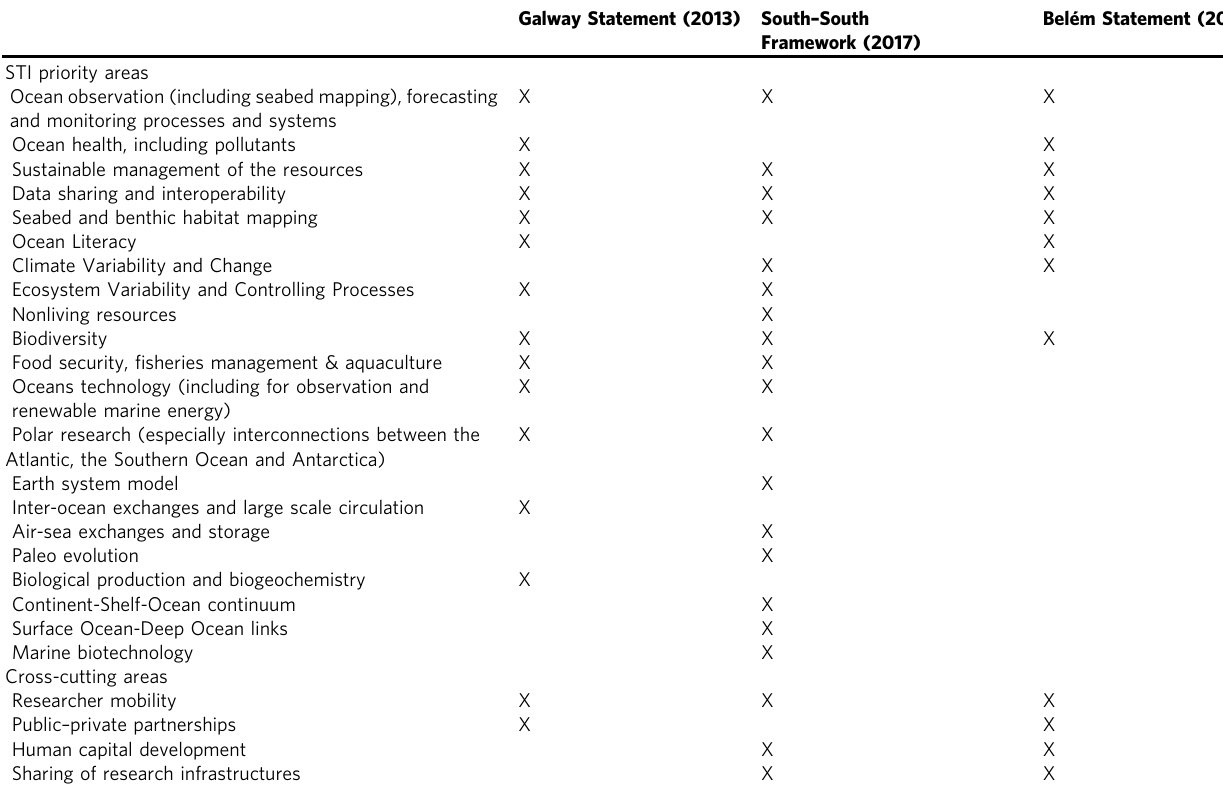
Table 1 Comparison among the priority areas de fi ned by each of the negotiation processes of the three Atlantic international arrangements on ocean research and development (STI: Science, Technology, and